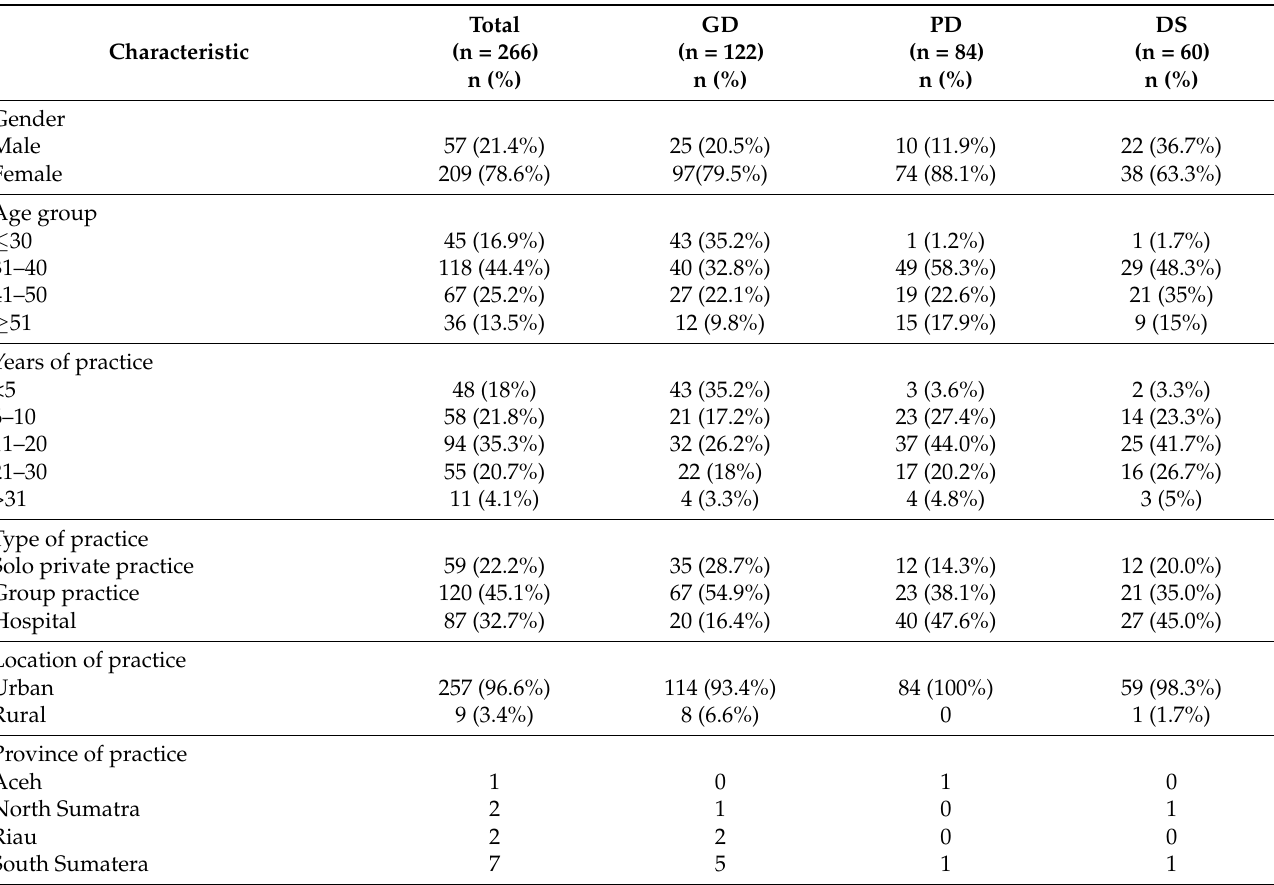
Table 1. Demographic characteristics of the study participants in Indonesia, categorised into general practitioners (GD), paediatric dentists (PD), and other speciality dentists